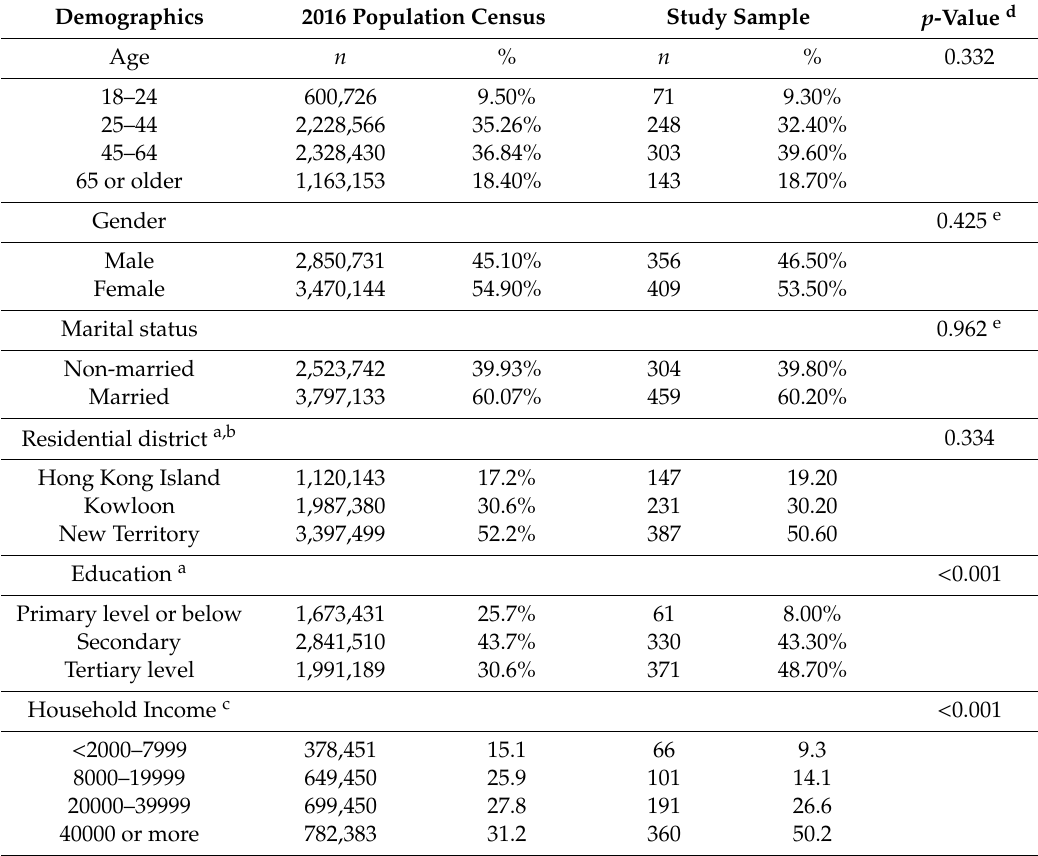
Table 1. The respondent’s socioeconomic characteristics and comparison with Census population